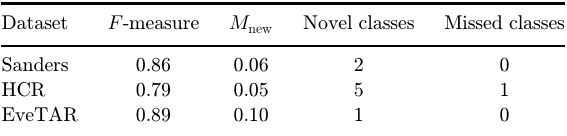
Table 5. Summary of the